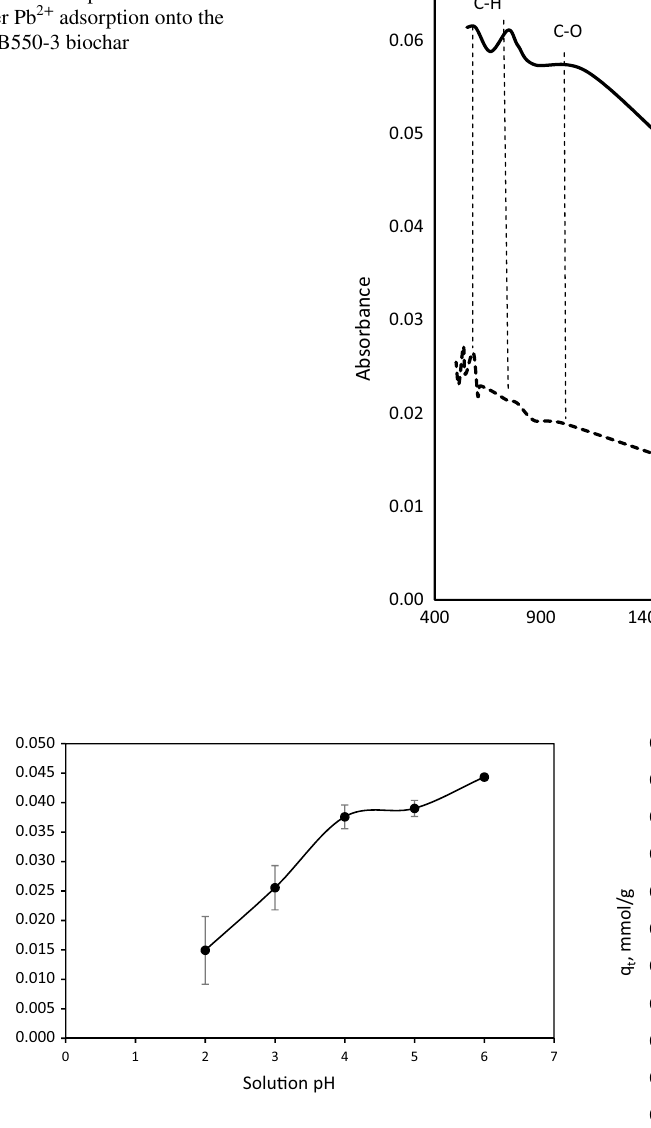
Fig. 4 Effect of solution pH on Pb 2+ adsorption onto DSB550-3 (ini- tial Pb 2+ concentration = 0.5 mM; temperature = 23 ± 2 °C; biochar dosage = 10 g L −1 ; particle size = 0.60–1.4 mm)